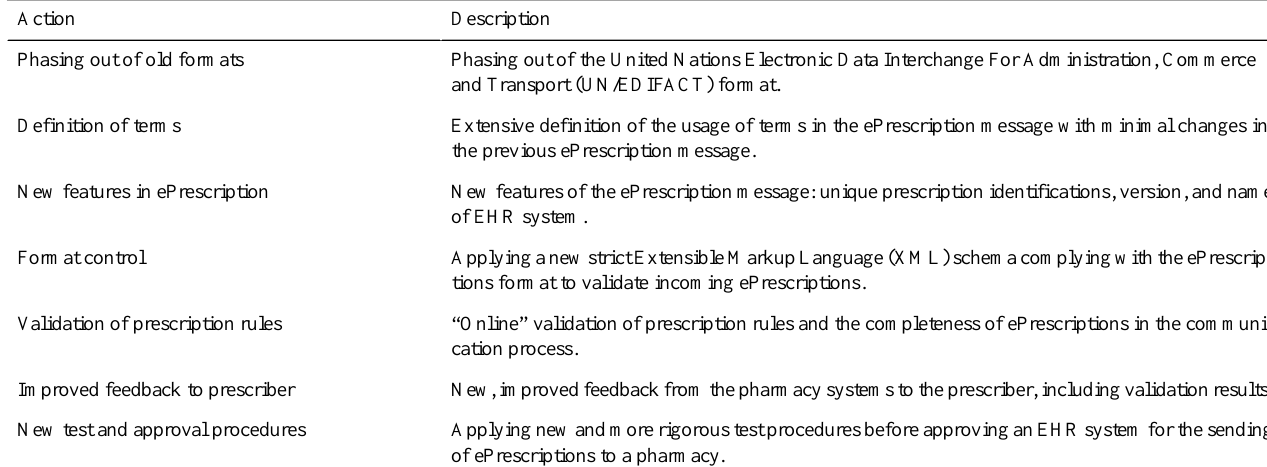
Table 2. Summary of actions taken with the introduction of NEF.